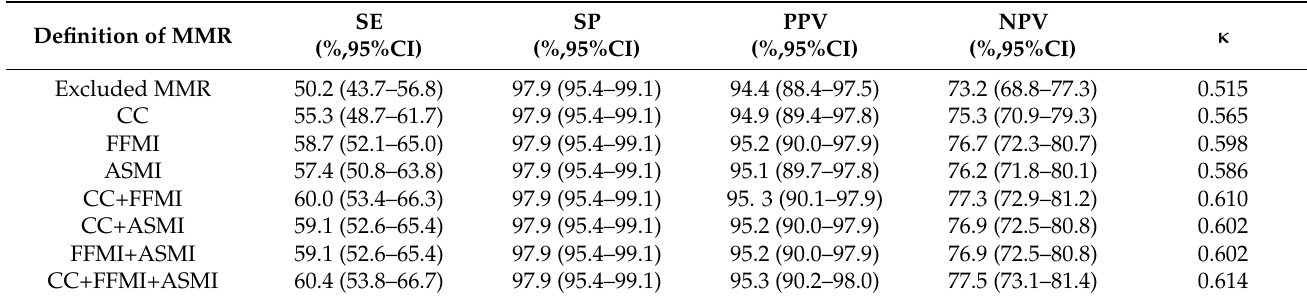
Table 4. SE, SP, PPV, and NPV of GLIM using any combination of phenotypic criteria and etiologic criteria in diagnosing malnutrition compared with PG-SGA.